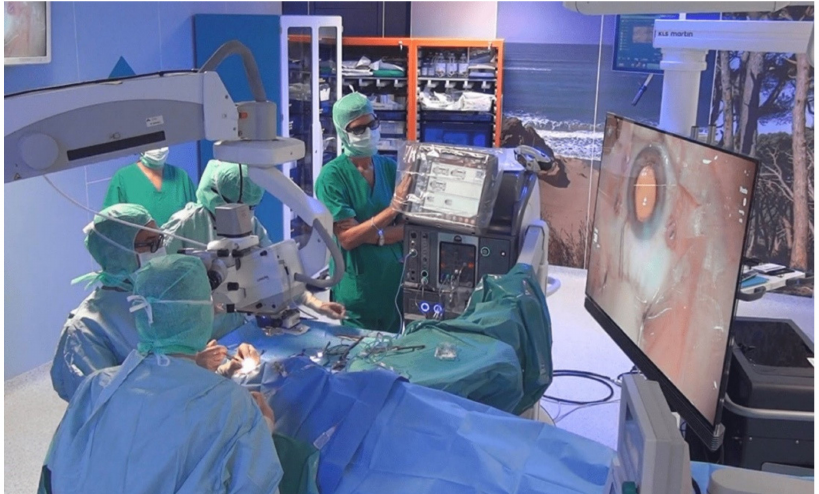
Figure 1. The surgeon operating with a “heads-up” position looking at the 3D monitor with the use of polarized